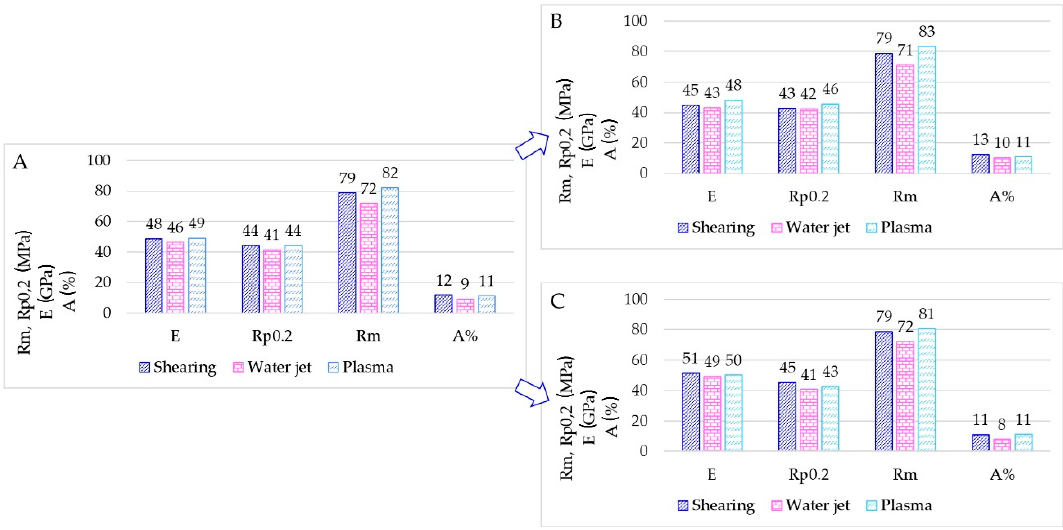
Figure 12. ( A ) Overall bar chart for MIG-welded sheets. ( B ) Bar charts for as-welded samples. ( C ) Bar charts for milled samples.